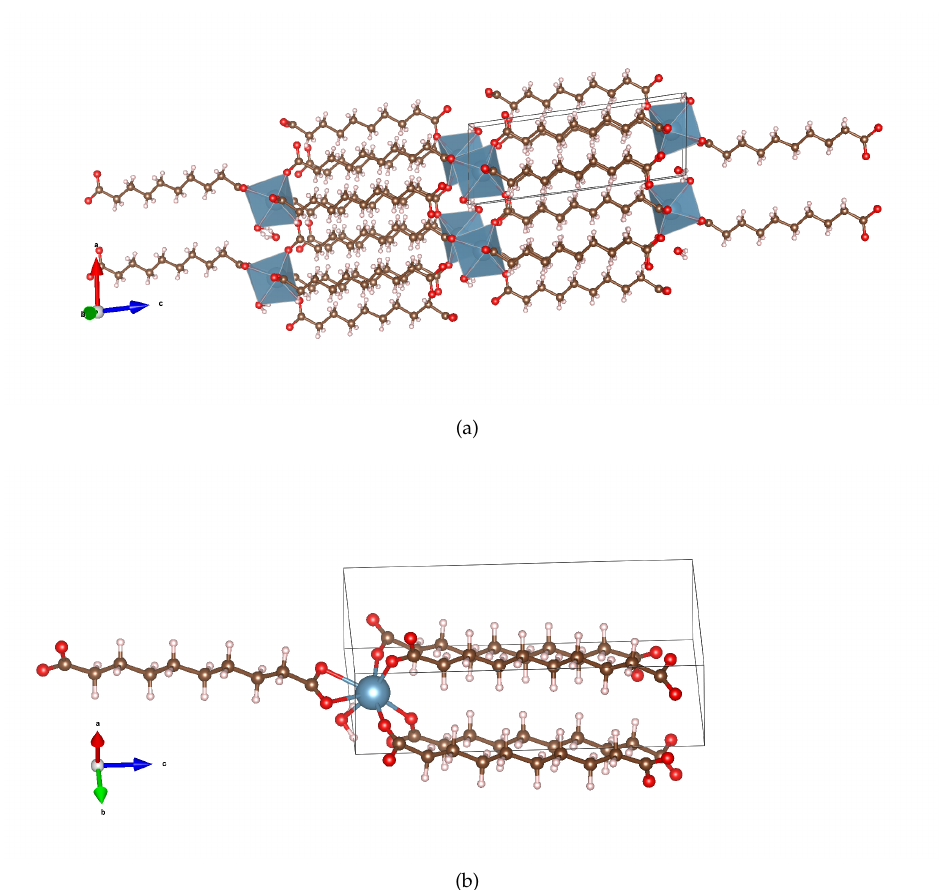
Figure 4. ( a ): packing of the title compound. ( b ): a detail of the distorted tetrahedral coordination of the calcium ion, operated by a water molecule and by carboxylic oxygen